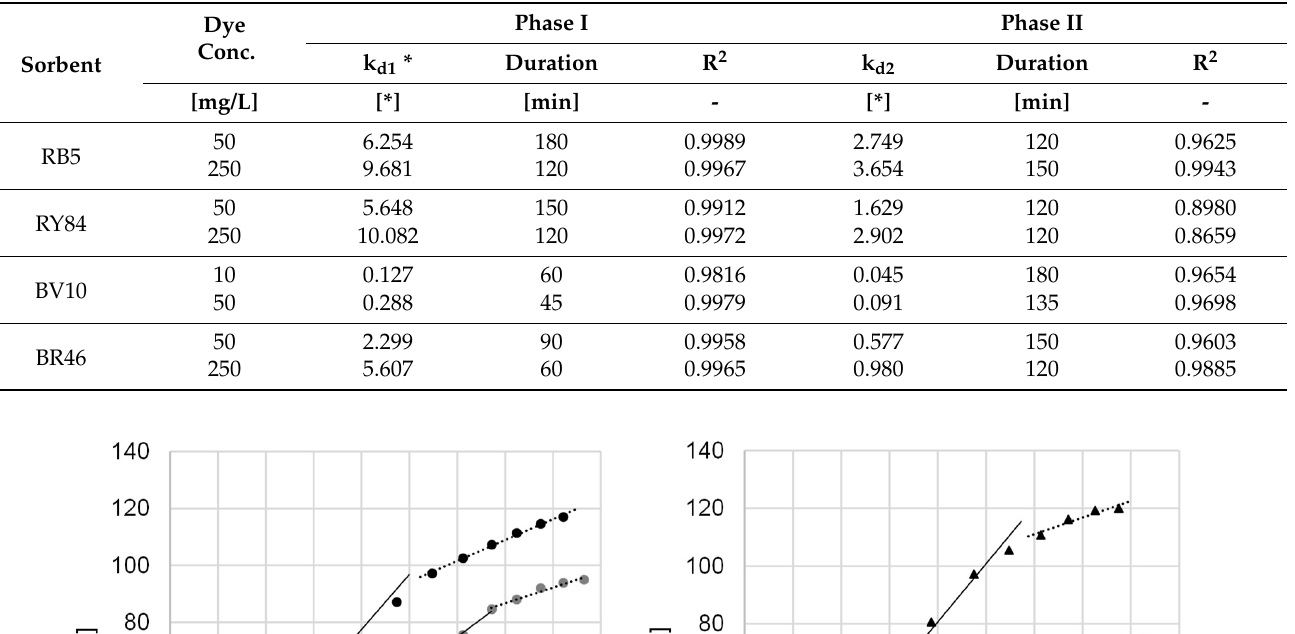
Table 3. Dye diffusion rate constants, determined from the intramolecular diffusion model.